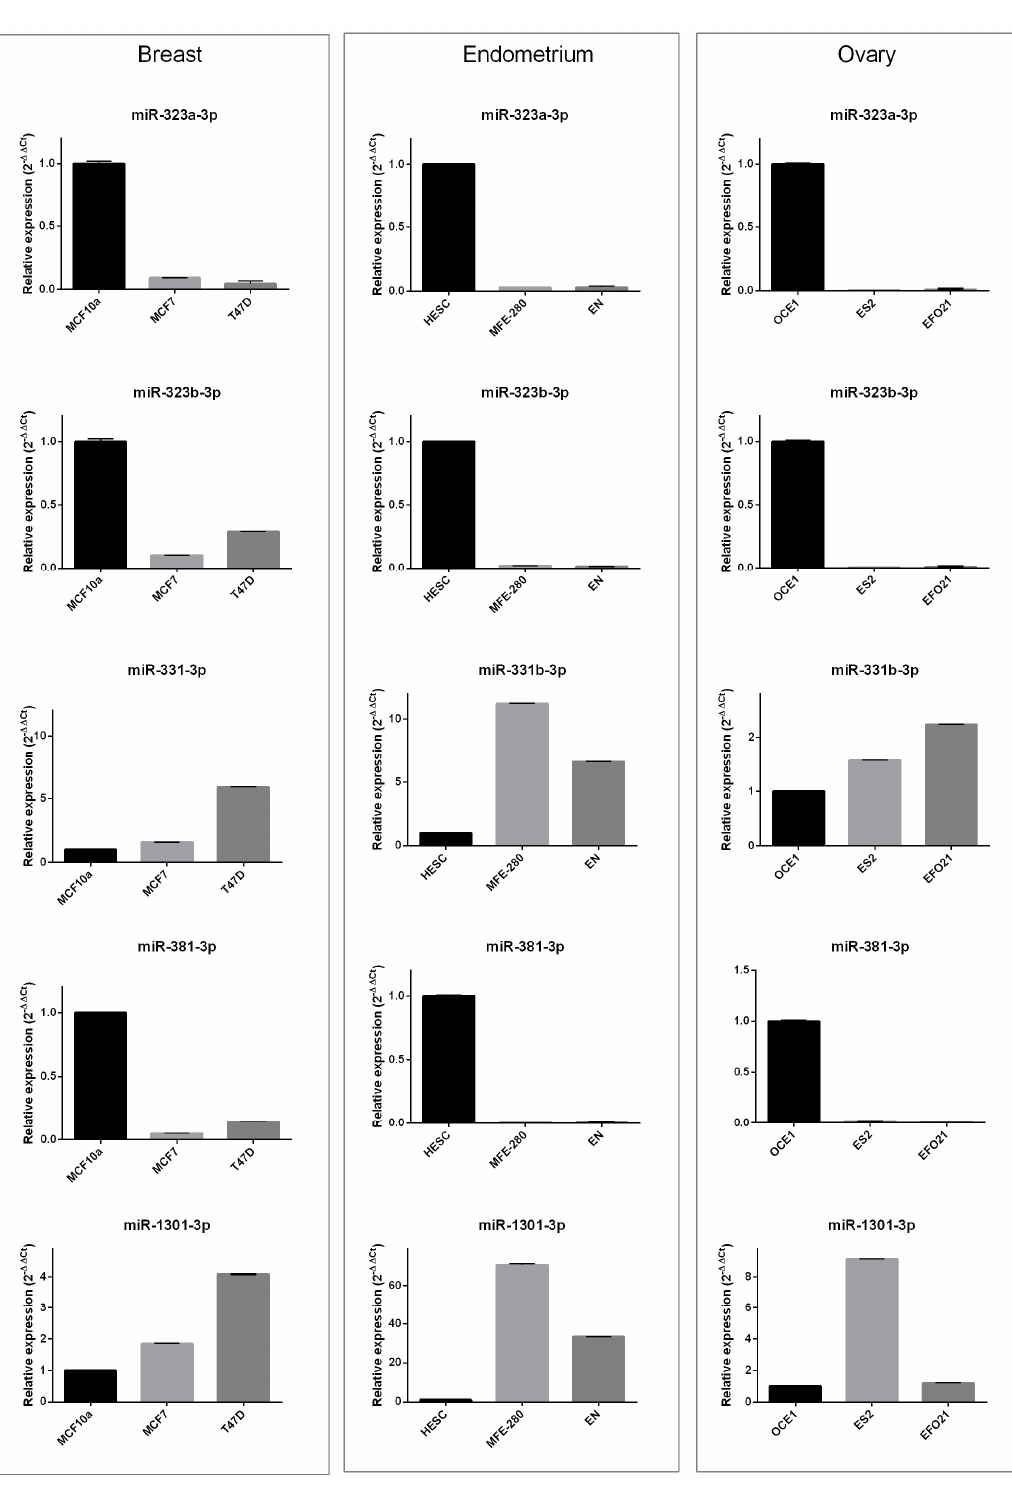
Figure 3. Relative expression of selected miRNAs in cancer vs. normal cell lines. Left panel: miRNA expression in normal breast (MCF10A) and breast cancer (MCF7 and T47D) cell lines. Middle panel: miRNA expression in normal endometrial (HESC) and endometrial cancer (MFE-280 and EN) cell lines. Right panel: miRNA expression in normal ovary (OCE1) and ovarian cancer (ES2 and EFO21) cell lines. miRNA expression was evaluated by real-time PCR (2 ‒ΔΔ Ct).